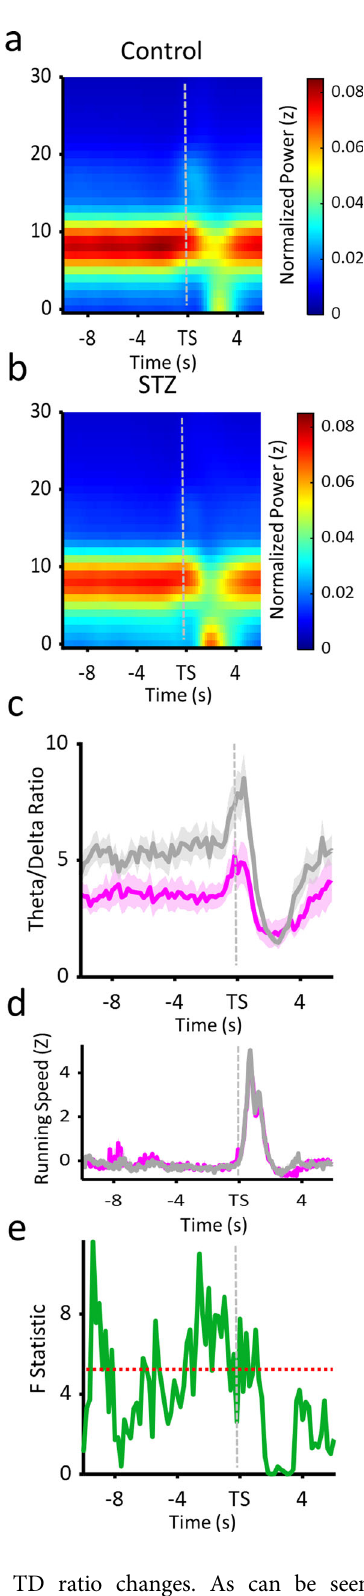
Fig. 4 Theta delta ratios during the end of the delay period. a , b Mean peri-event spectrograms for the hippocampus of control ( a ) and STZ ( b ) groups. Frequency is shown on the y -axis and time relative to trial start (TS) is on the x -axis. c Mean peri-event theta delta ratios for the hippocampus. TD ratio values on the y -axis and time relative to trial start is on the x -axis. Gray lines show control group value and magenta show STZ. Shaded error bars show standard error of the mean. d Mean running speed. Normalized running speed values are shown for the control (gray) and STZ (magenta) groups over the same time period as plots c , d . e Running F tests for TD ratios for the hippocampus. TD ratios from all trials were compared at each time step (500 ms) between the two groups with a single-factor ANOVA. F value is on the y -axis and time relative to trial start is on the x -axis. The red dotted lines show the level for signi fi cance at p < 0.05; Bonferroni corrected. Error bars =